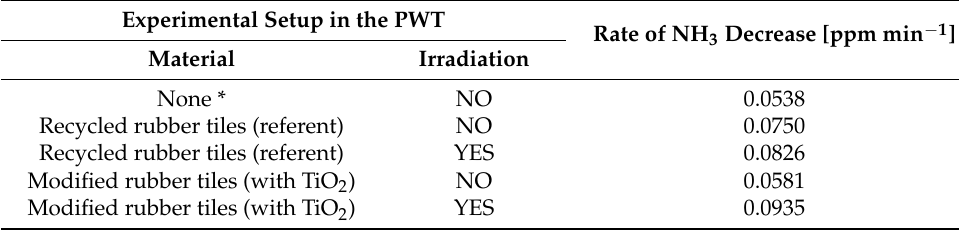
Table 6. Experimentally determined rates of NH 3 content decrease in the PWT. Experimental Setup in the